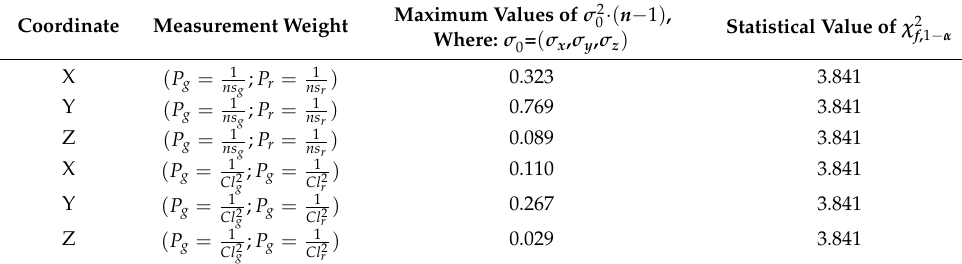
Figure 12. Mean errors of the arithmetic means ( M x , M y , M z ) from the adjustment scheme ( P g = 1 ) . ; P g = 1 Cl 2 g Cl 2 r